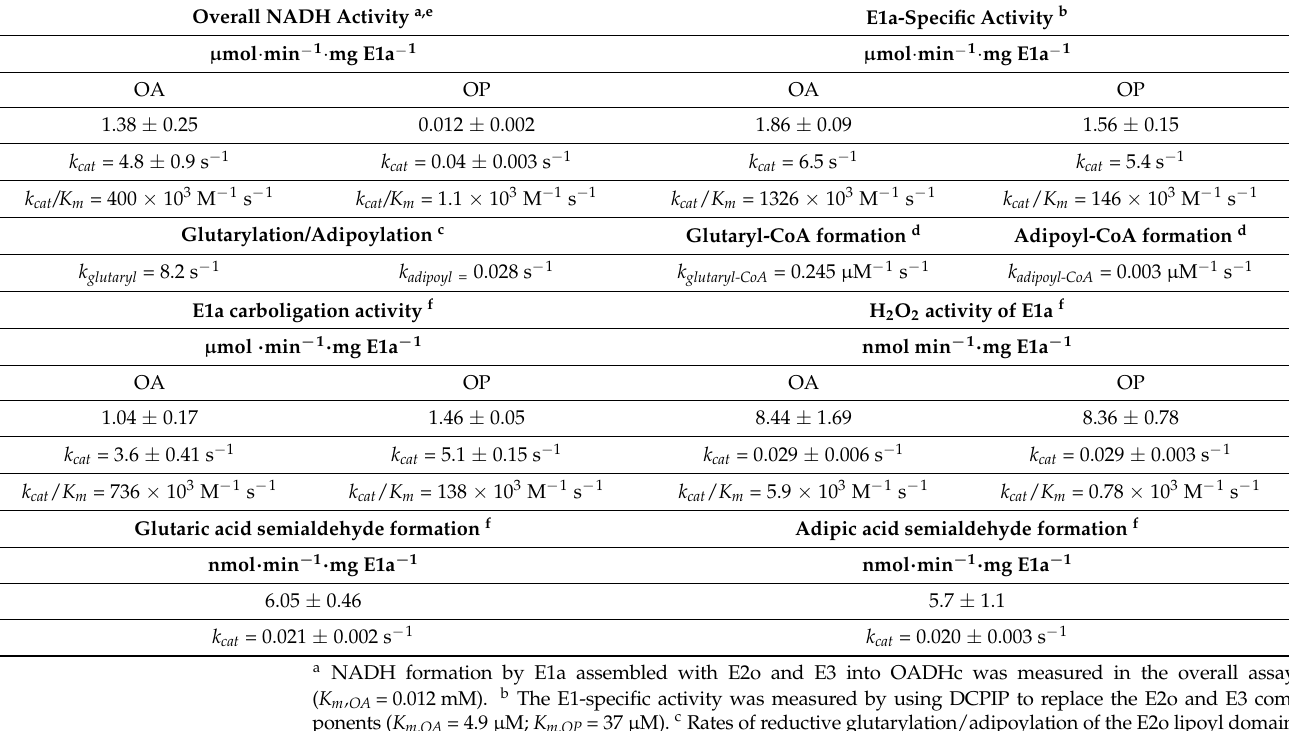
Table 1. Comparison of the E1a-specific and OADHc complex activities with OA and